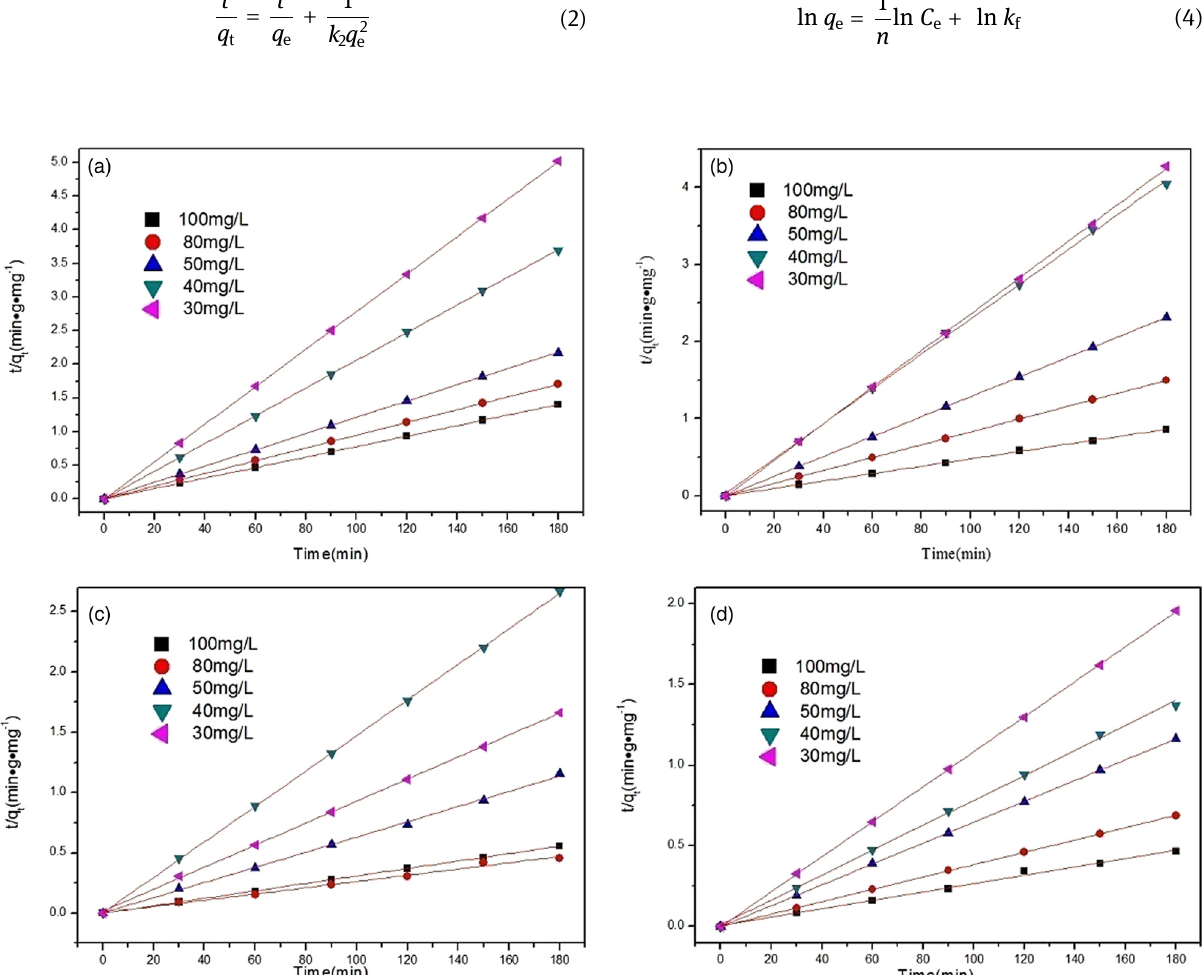
Figure 5: Pseudo - second - order kinetic model for the adsorption over the Sm - MOF: ( a ) m = 100 mg, ( b ) m = 80 mg, ( c ) m = 50 mg, and ( d ) m = 40